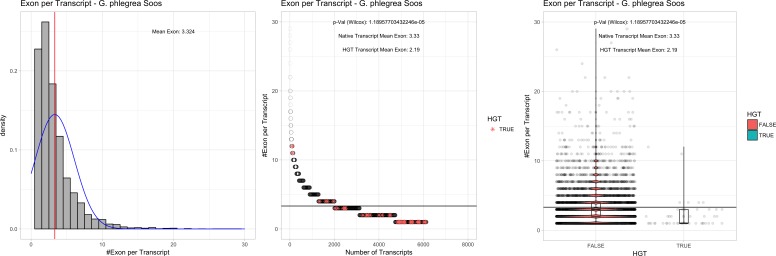
Exon/Intron – Galdieria phlegrea Soos: (Left) Mid) Cumulative %GC distribution of transcripts.Red line shows the average, blue line a normal distribution based on the average value. The data is categorical (genes have either one, two, three etc. exons) and does not follow a normal distribution. (Mid) Ranking all transcripts based upon their number of exons. Red ‘*' demarks HGT candidates. As the number of exons was not normally distributed, transcripts were ranked by number of exons. In order to resolve the high number of tied ranks (e.g. many transcripts have two exons) a bootstrap was implied by which the rank of transcripts sharing the same number of exons was randomly assigned 1000 times. Wilcoxon-Mann-Whitney-Test applied for the determination of significant rank differences between the native gene and the HGT candidate subset. (Right) Violin plot showing the number of exons per transcript distribution across native transcripts and HGT candidates.